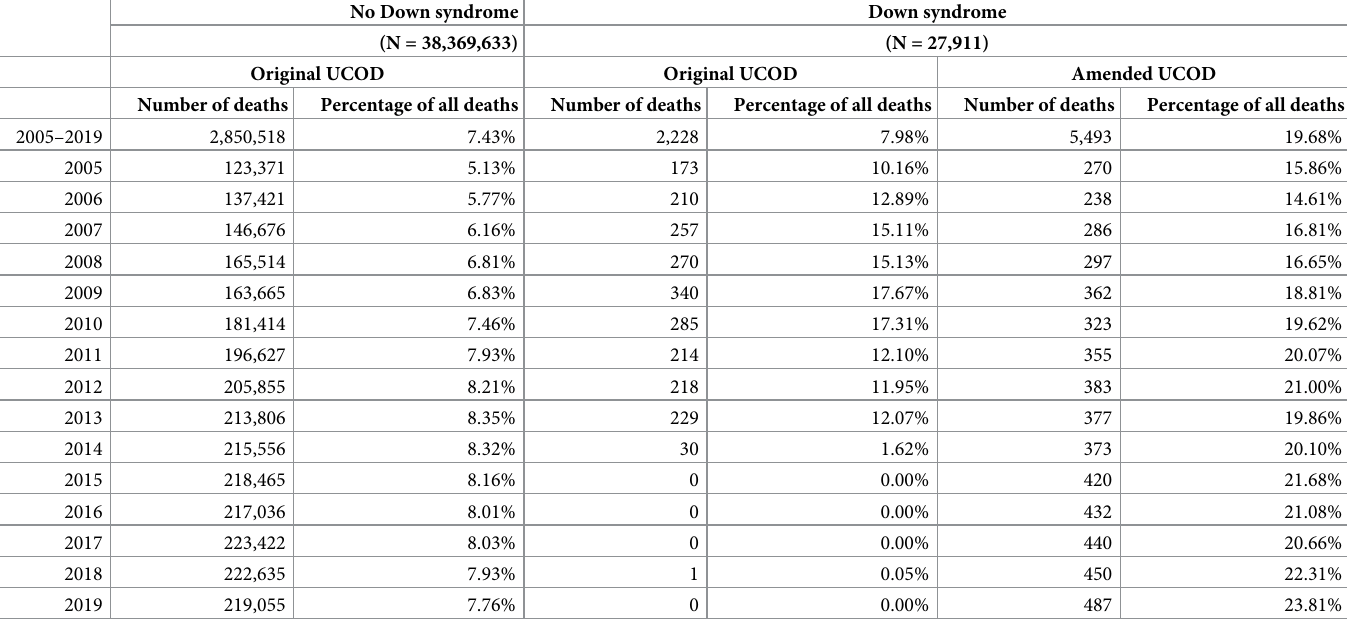
Table 1. Alzheimer disease or unspecified dementia death patterns among adults with/without Down syndrome, 2005–2019. No Down